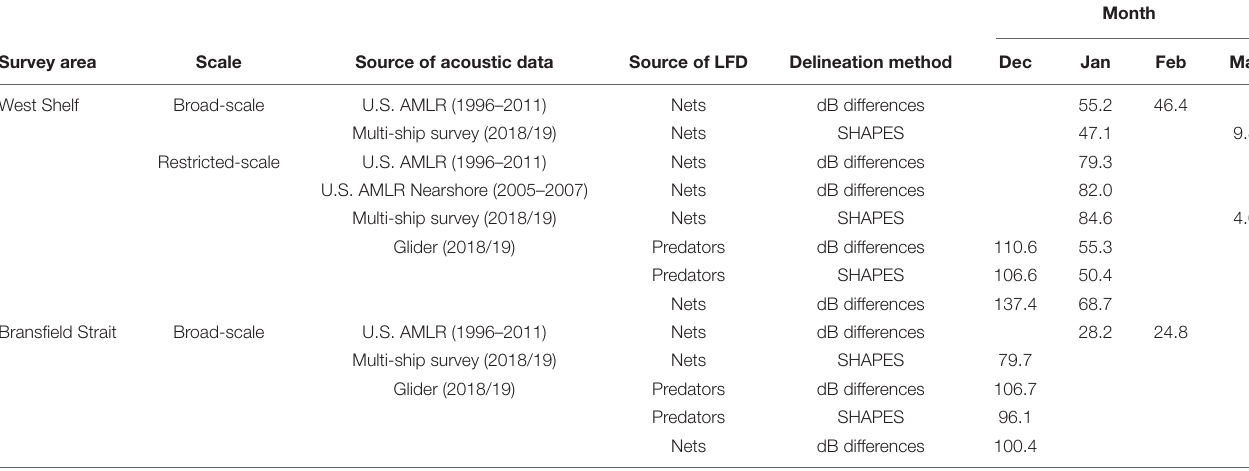
TABLE 2 | Estimates of the mean biomass density (g m − 2 ) of krill over the West Shelf and in the Bransfield Strait.